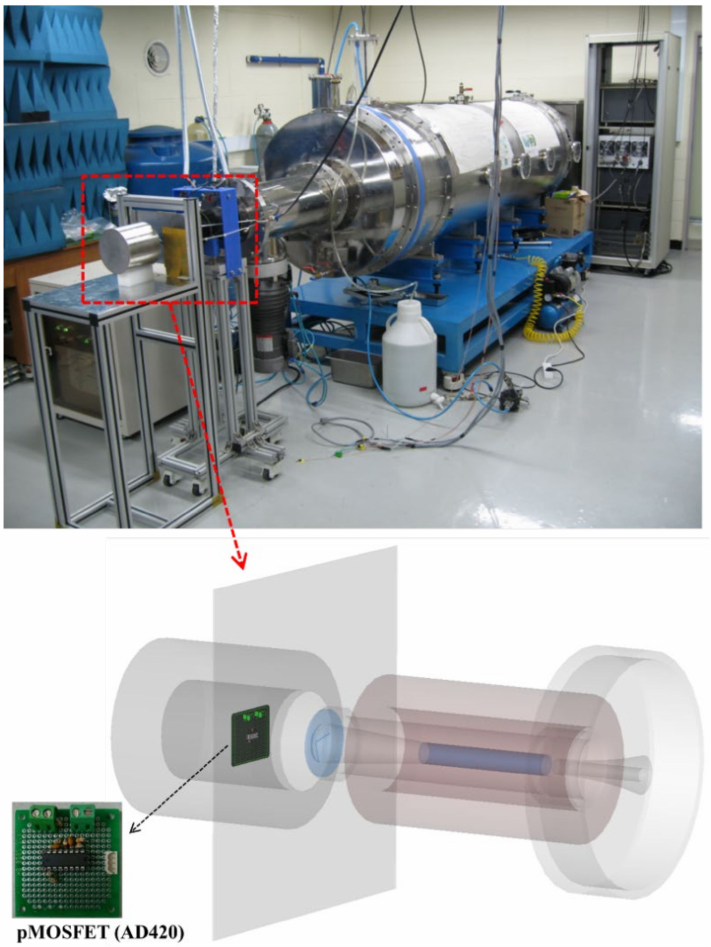
Figure 2. Experimental setup for positronium (Ps) generation with the arrangement of gamma-ray detector using semiconductor